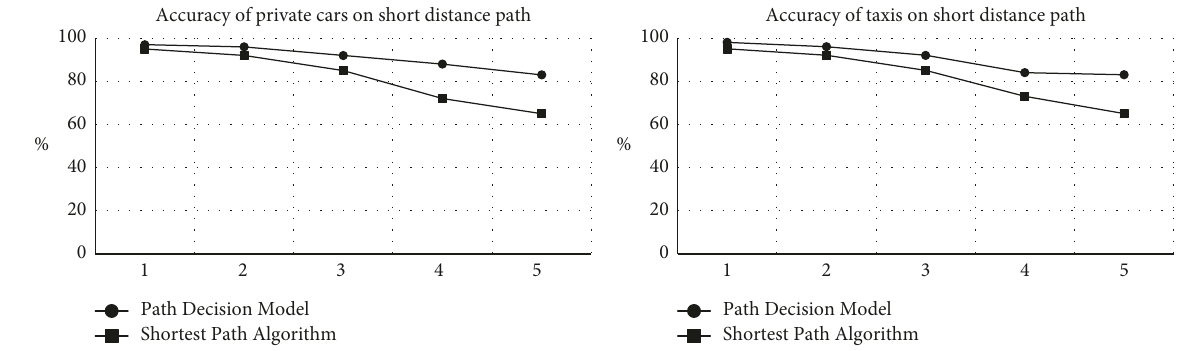
Figure 9: Accuracy of taxis and private cars on short-distance path.